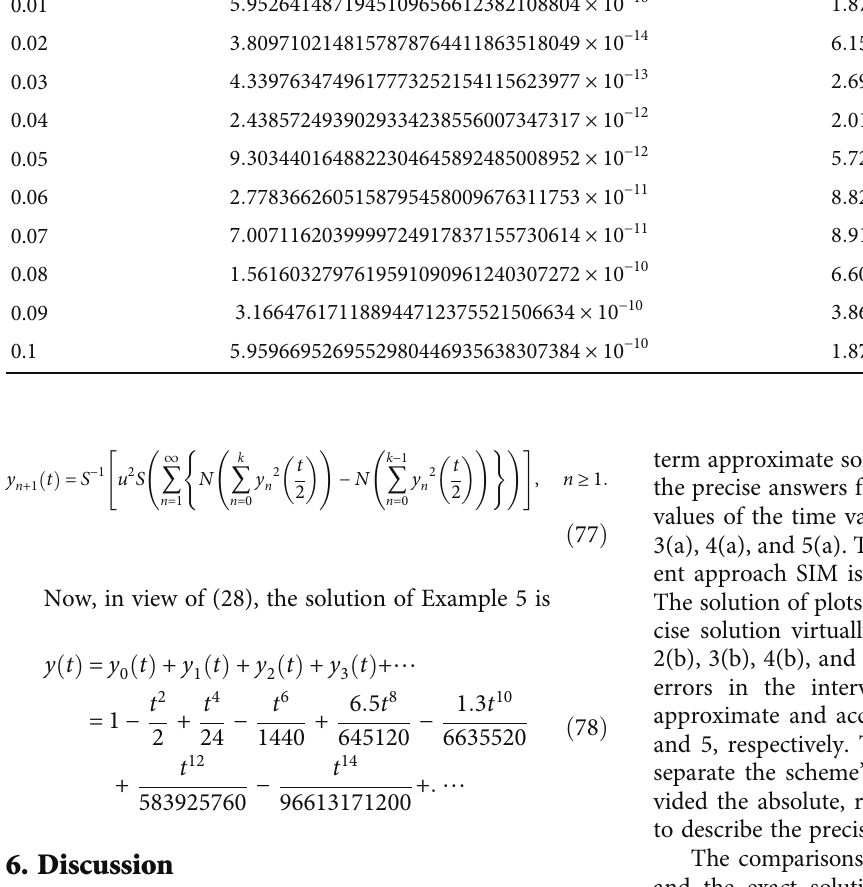
− y 8 7 j of the eight-term approximate solution with di